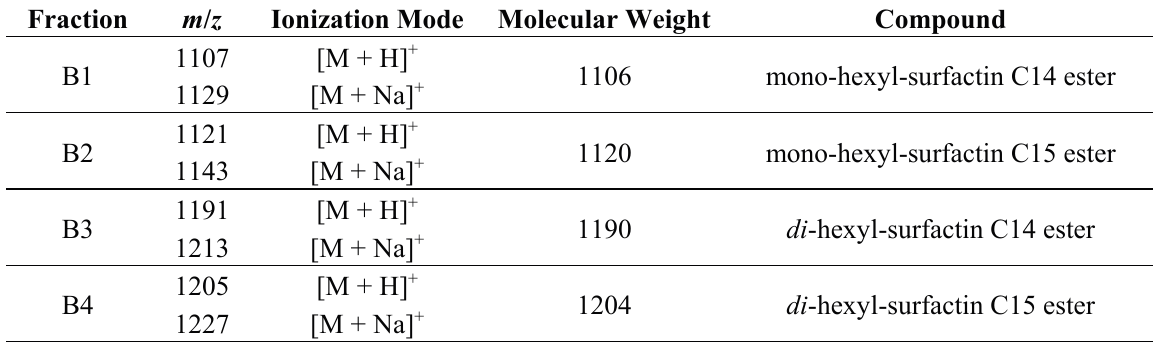
Table 1. Component identification results of B1, B2, B3 and